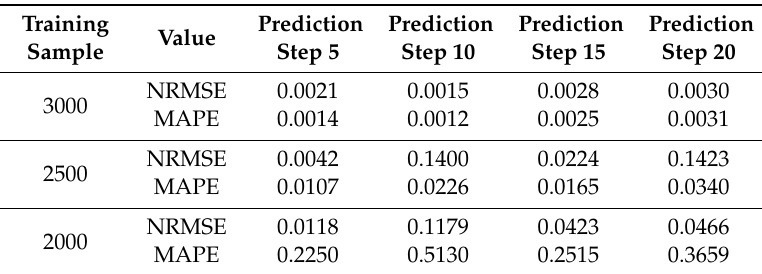
Table 1. The analysis of prediction results based on normalized root mean square error (NRMSE) and mean absolute percentage error (MAPE).